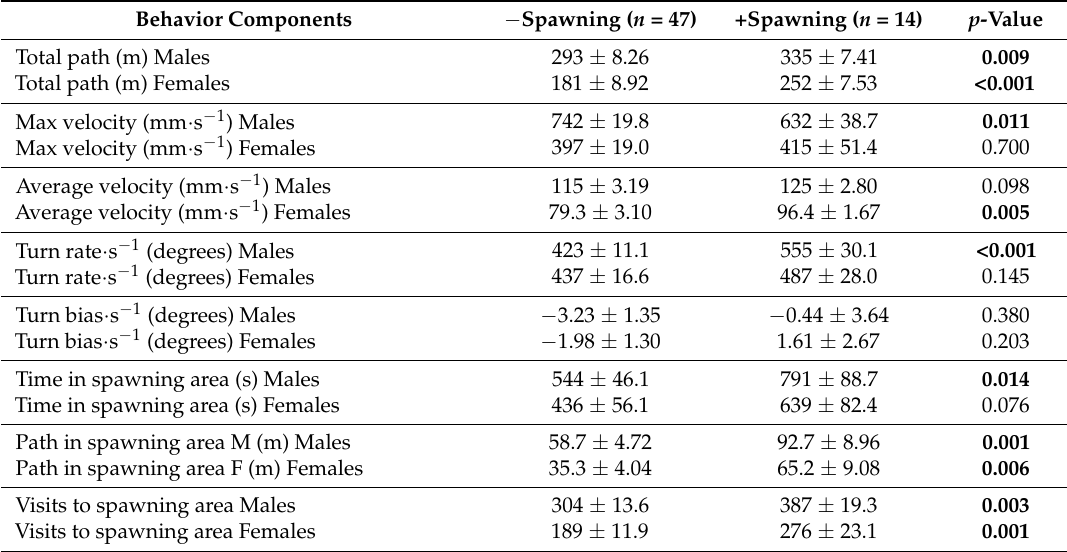
Table 2. Differences in behavior in spawning and non-spawning zebrafish pairs where the males were exposed to 1.26 ng · EE2 · L − 1